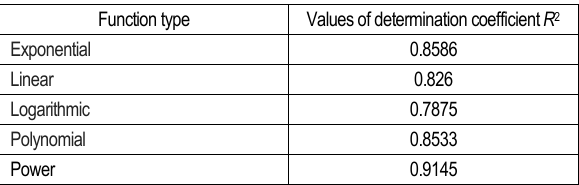
Table 2. Interim calculations to determine the type of